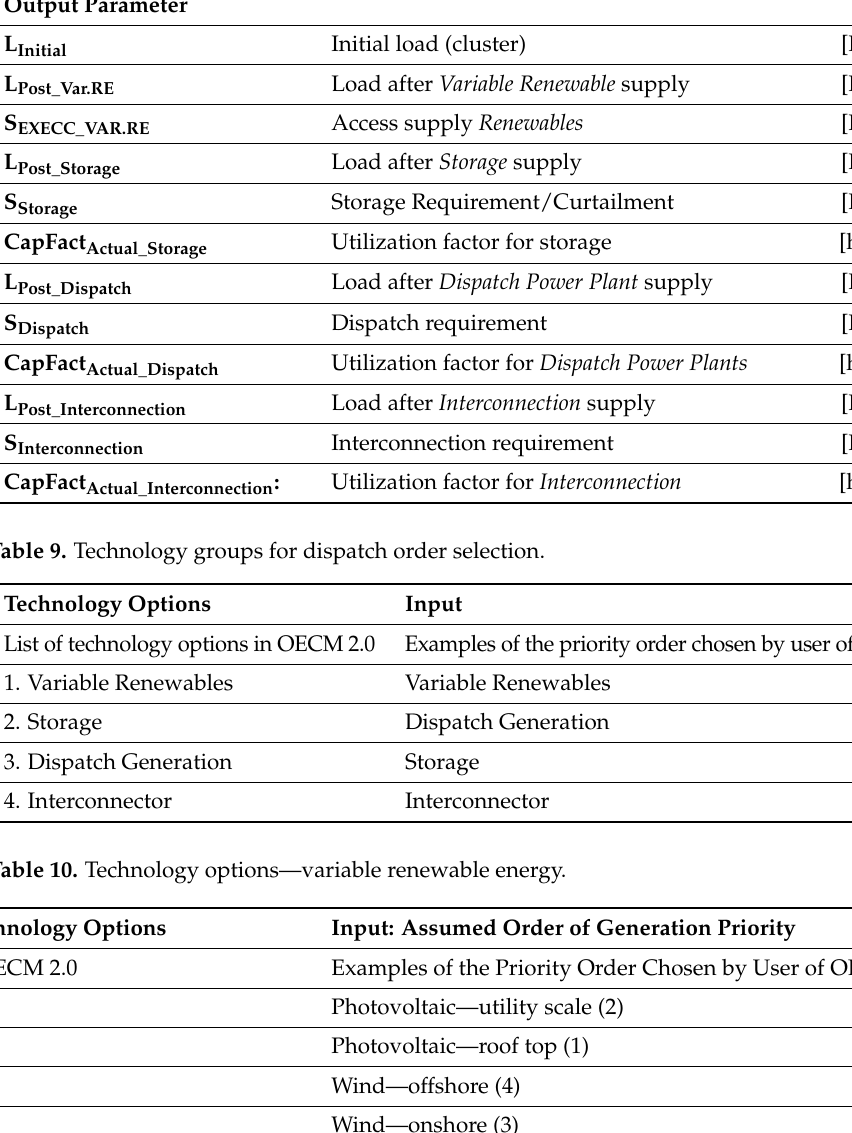
Table 8. Output parameters for the dispatch model.